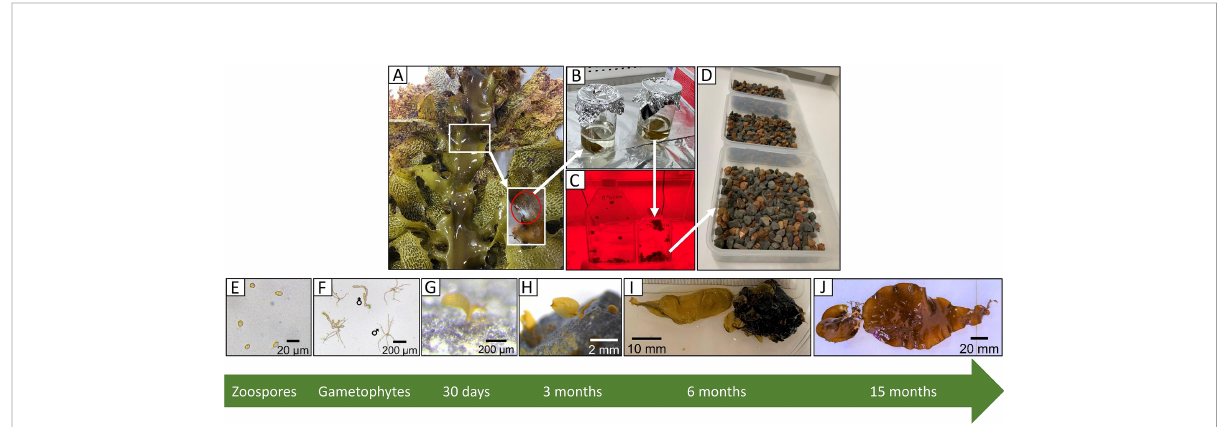
FIGURE 1 Green gravel work fl ow (A-D) and zoospore development into juvenile sporophytes (E-J) . (A) Collection of fertile thalli with inset showing sori tissue, (B) inducing zoospore release in the laboratory, (C) establishing gametophyte stock cultures from the zoospore suspension, (D) seeding green gravel by adding the fragmented gametophyte suspension to trays containing small rocks. (E) Settled zoospore (1 day), (F) male and female gametophytes (2 weeks), (G, H) microscopic sporophytes on green gravel (1, 3 months), and (I, J) macroscopic juvenile sporophytes on green gravel (6, 15 months). Photo credits: (A, C, D, E-I) N. Alsuwaiyan, (B) A Minne, (J) M.